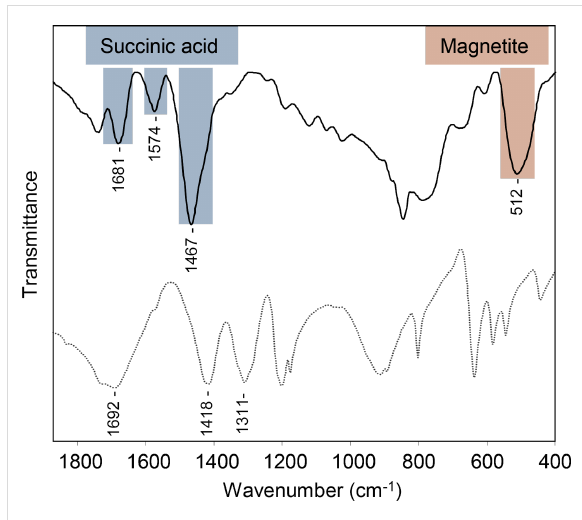
Figure 4: FTIR spectrum of USM-Suc nanoparticles (solid line) and succinic acid (dotted line) as a reference. Highlighted signals are discussed in the text.